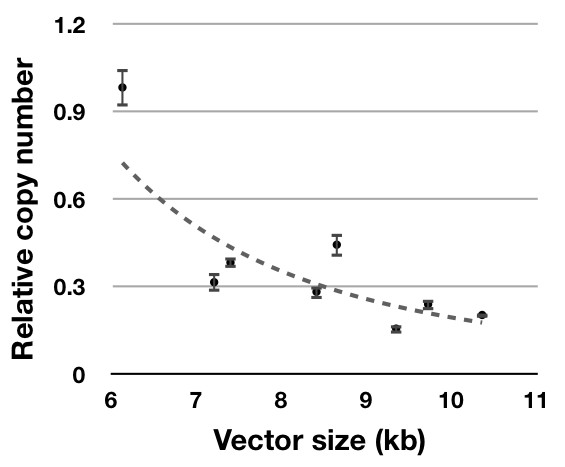
Correlation between relative copy number and vector size. Relative vector copy number, analyzed by real-time PCR, decreased exponentially as vector size increased. The graph and R2 were created with Microsoft Office Excel.